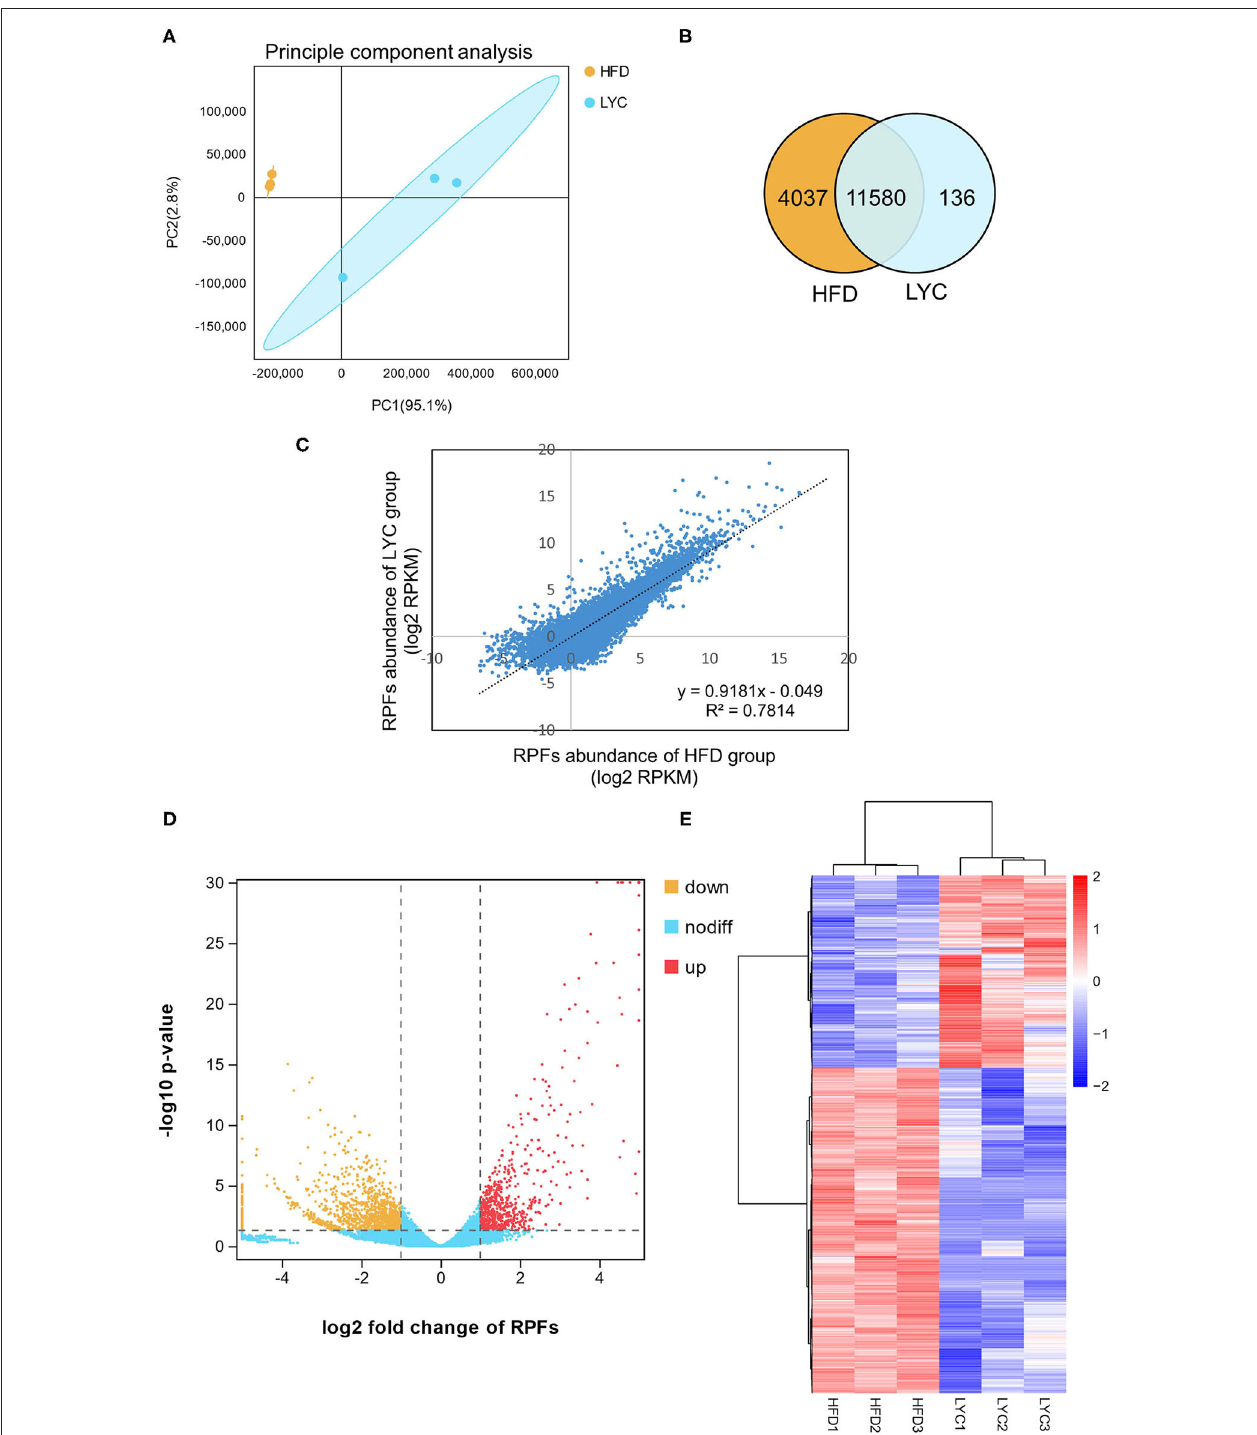
FIGURE 3 | Overview of Ribo-seq results in HFD and LYC mice livers. (A) Principal component analysis of Ribo-seq. (B) Venn diagram showing number of common genes among the two groups. (C) RPFs abundance correlation scatter plot between HFD and LYC livers. (D) Volcano plots indicate the directionality of significant DEGs. Genes upregulated (red) or downregulated (orange) by supplement lycopene correspond to a 1.0 decrease or increase in log 2 fold change with p < 0.01. (E) A total of 1,358 DEGs were clearly distinguished based on their Ribo-seq abundance. The color key (from blue to red) of Z -score value ( − 2–2) indicated low to high expression levels. HFD1, HFD2, and HFD3 represent group HFD biological repetition 1, 2, and 3. LYC1, LYC2, and LYC3 represent group LYC biological repetition 1, 2, and 3.